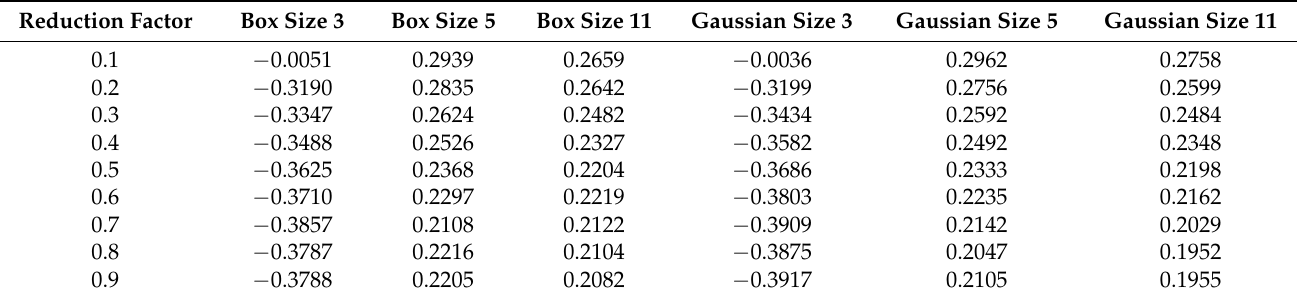
Table A2. Parameter value combination